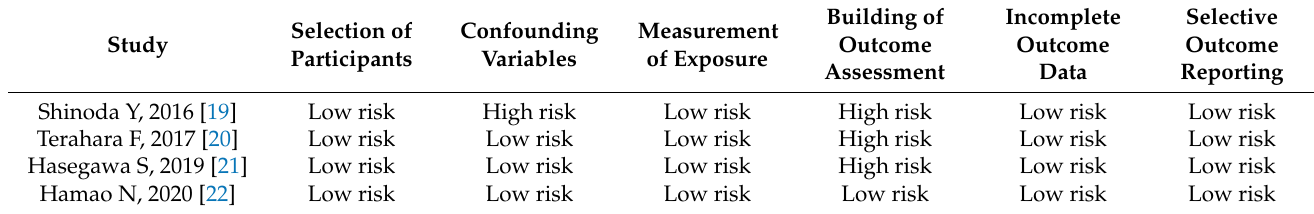
Table 2. Risk of bias in the included